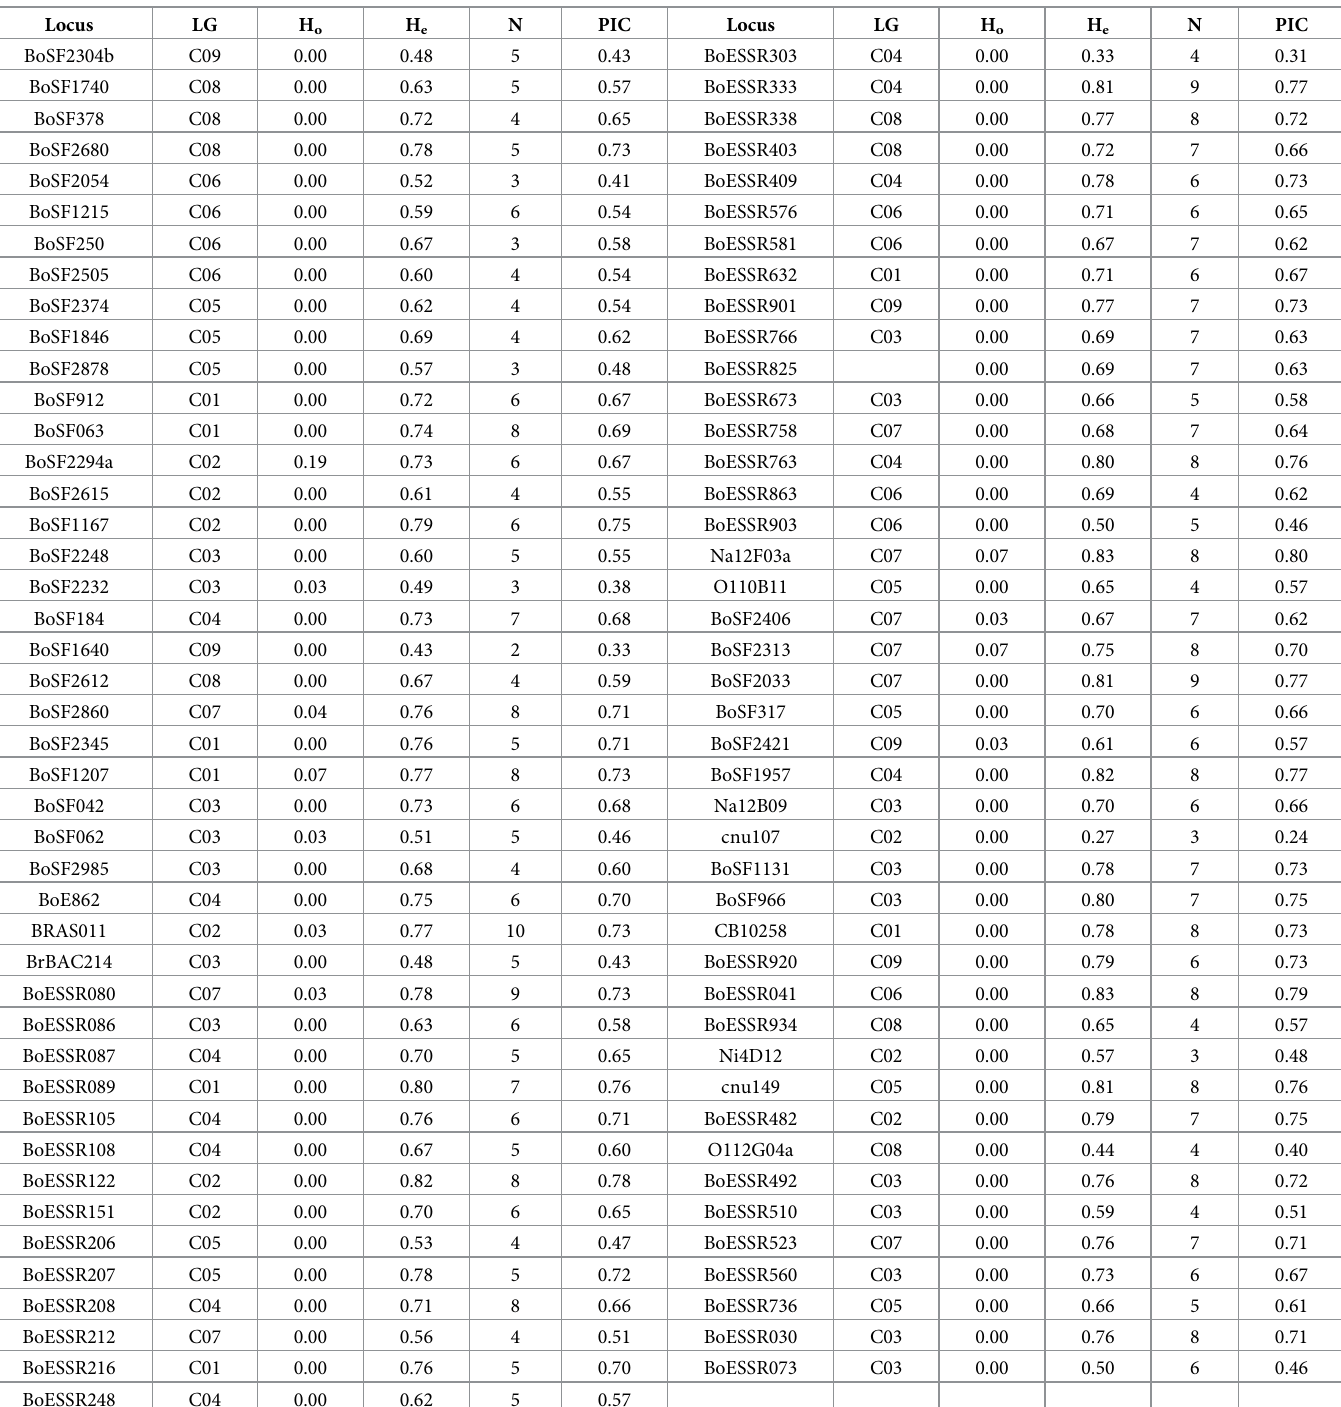
Table 6. Characteristics of 87 polymorphic SSR and EST-SSRs loci depicting